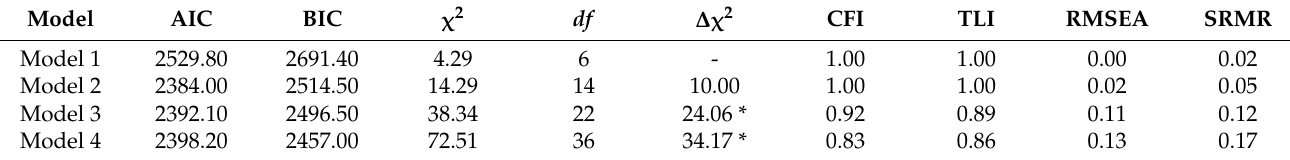
Table 9. Comparison of the hypothesized model.